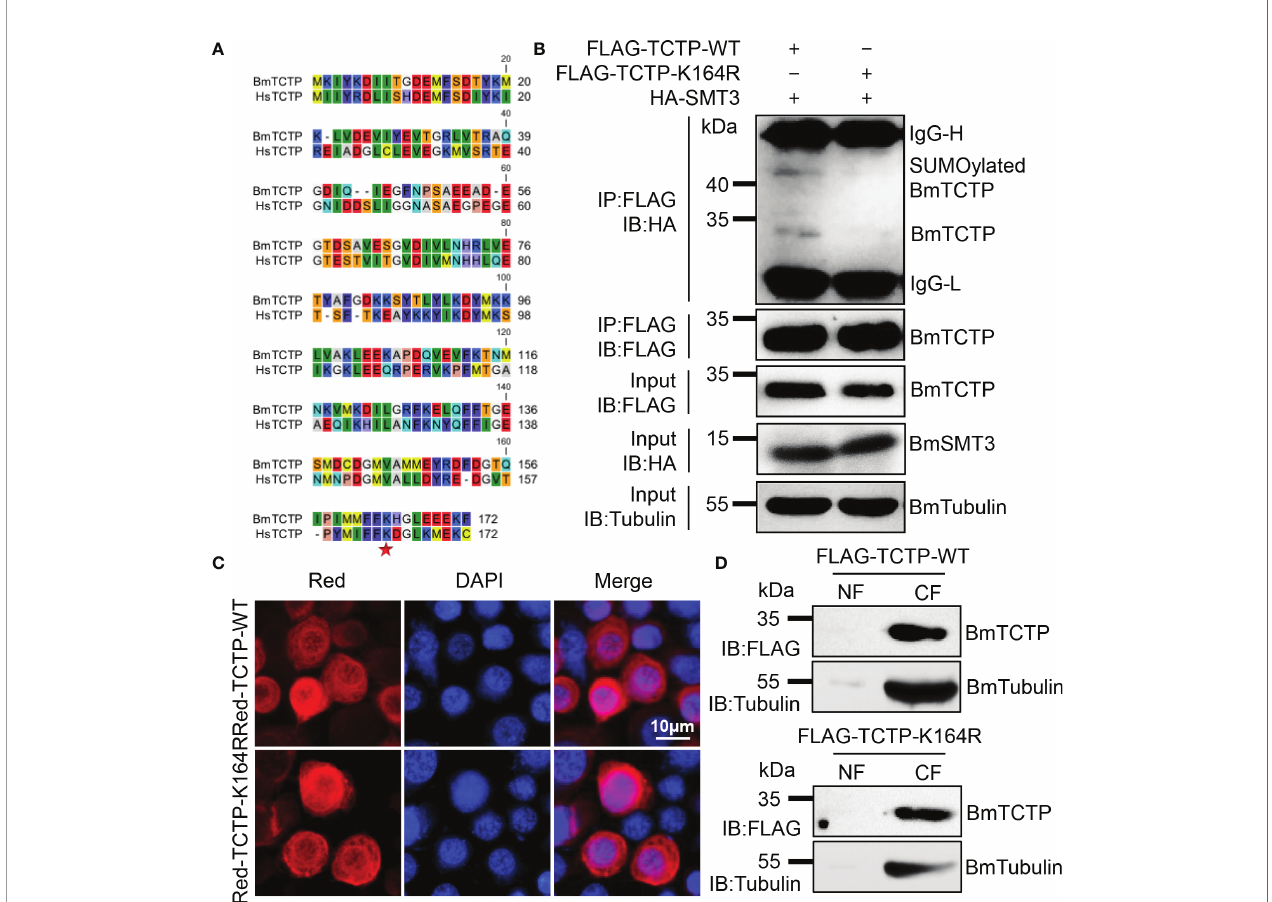
FIGURE 1 | Bombyx mori translationally controlled tumor protein ( BmTCTP ) was SUMOylated at a conserved lysine site in silkworm. (A) The amino acid sequence alignment was performed using the CLC sequence viewer 7 software on human and silkworm sequences of TCTP. Asterisk indicated residue of the potential SUMOylation site. (B) Plasmids as indicated were co-transfected into the silkworm BmN cells. Lysates from BmN cells were used for immunoprecipitation with anti- FLAG antibody, followed by immunoblotting with indicated antibodies. IgG-L and IgG-H were the light and heavy chains of anti-FLAG antibody. (C) Subcellular localization of Red-TCTP-WT or Red-TCTP-K164R fusion protein in BmN cells was determined by fl uorescence (red), and the nuclear DNA was counterstained with 4 ’ ,6-diamidino-2-phenylindole (DAPI) (blue). Scale bar, 10 m m. (D) Cytoplasm (CF) and nuclear (NF) fractions isolated from BmN cells expressing FLAG-TCTP-WT or FLAG-TCTP-K164R were probed with an anti-FLAG antibody. An anti-Tubulin antibody was used to label